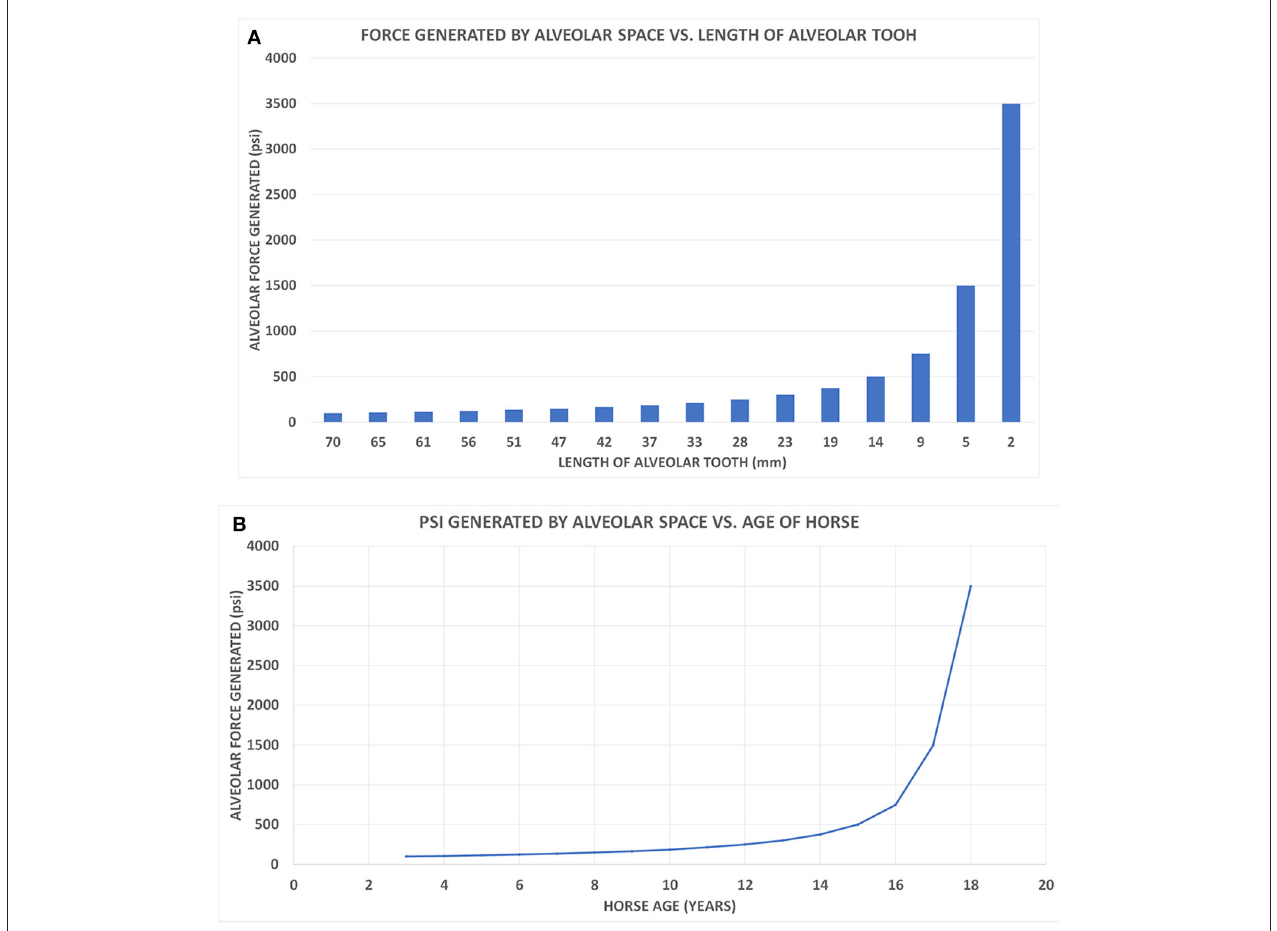
FIGURE 4 | (A) The alveolar force F α vs. the alveolar length L α shown on a bar chart to correspond with the age of the horse when read from left to right. (B) The graph displays the force generated by the alveolar space ( F α ) vs. the age of the